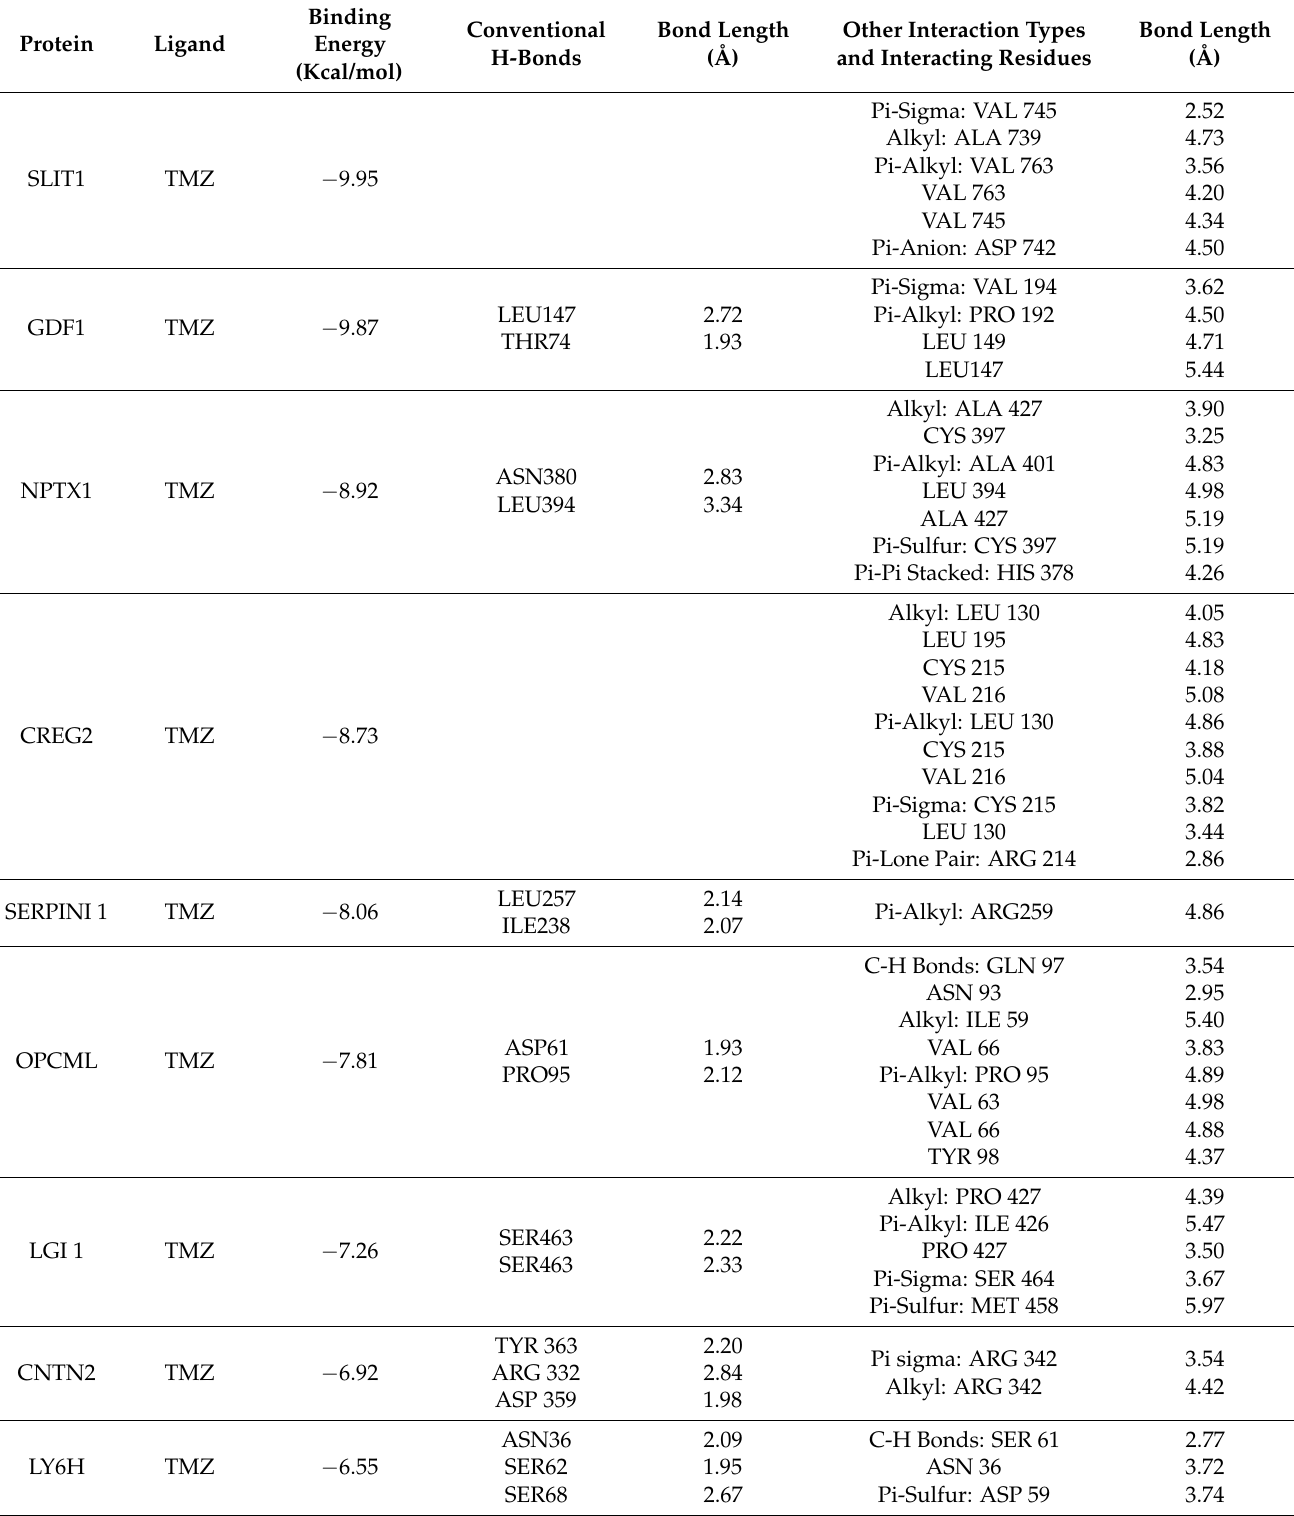
Table 1. Docking interaction of TMZ with the target